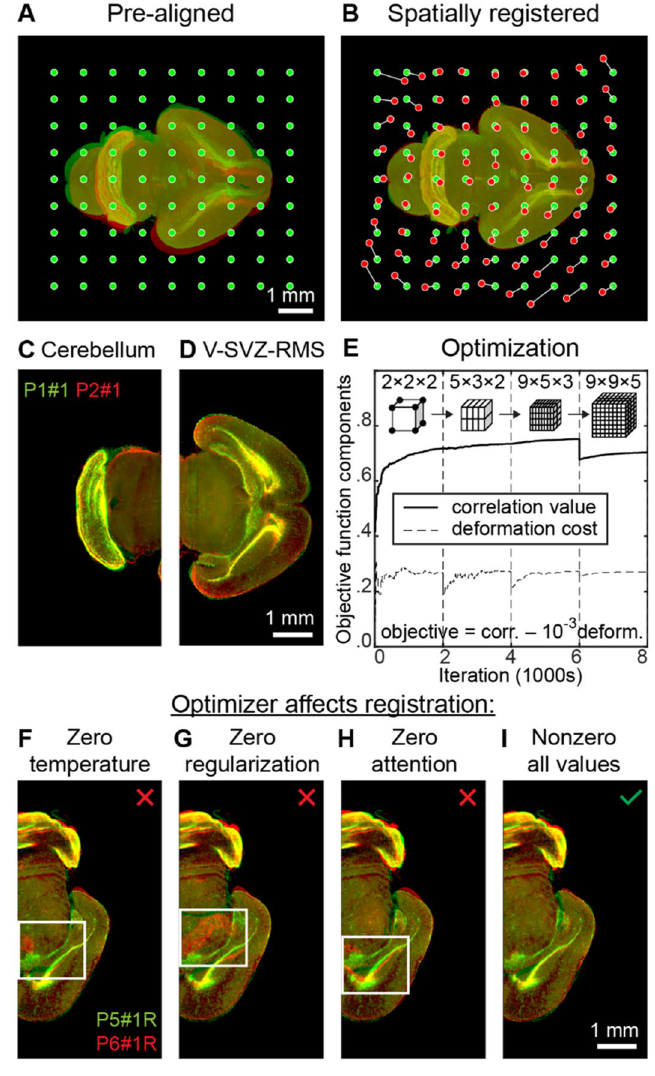
Figure 3. The simulated annealing algorithm allows registering dissimilar developing brains. ( A ) Two brain samples before alignment and the nodes of transformation grid. ( B ) Registered brain samples and displacements of the nodes of the transformation grid. ( C ) Registered cerebellum and ( D ) ventricular-subventricular zone (V-SVZ) and rostral migratory stream (RMS). ( E ) Pearson correlation (similarity) between two filtered brain images (solid line) and deformation cost for the registered brain (dashed line) throughout the simulated annealing registration. The objective function maximized with simulated annealing is a weighted difference between correlation value and deformation cost (1:1000). Simulated annealing is performed in 4 stages, separated by vertical dashed lines, corresponding to different numbers of cells in the transformation grid (2 × 2 × 2; 5 × 3 × 2; 9 × 5 × 3; 9 × 9 × 5) and different image resolutions, defined by linear voxel size (96 µm; 96 µm; 96 µm; 48 µm). The drop of similarity at iteration 6000 is due to refinement of the voxel size (96 µm → 48